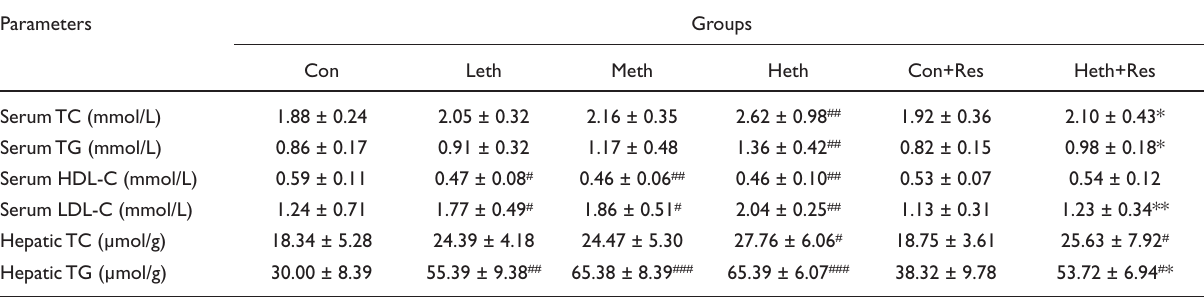
Table 2. Lipid metabolism parameters in the blood serum and liver of rats after chronically ethanol intake with or without Resveratrol supplemented Parameters Groups